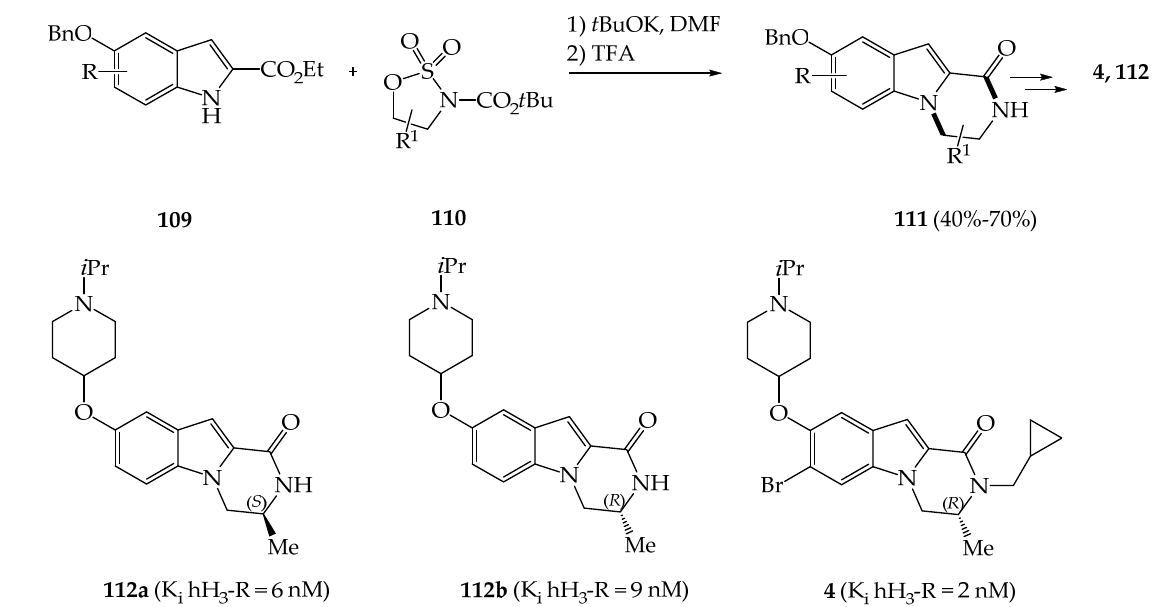
Figure 4. Overview of pyrazino[1,2- a ]indol-1-ones having biological properties. We now hope that all the observations reported in this review could open very inter- esting perspectives in medicinal chemistry (anti-cancer, anti-infectious, anti-allergenic, and others). These outlooks will quickly incite medicinal chemists to design new effective and selective ligands based on these types of chemical structures. Author Contributions: Conceptualization, O.P.; writing—original draft preparation, O.P., C.T., and A.H.; writing review and editing, O.P., M.A., and A.H.; bibliography, O.P. and K.Z. All authors have read and agreed to the published version of the manuscript.